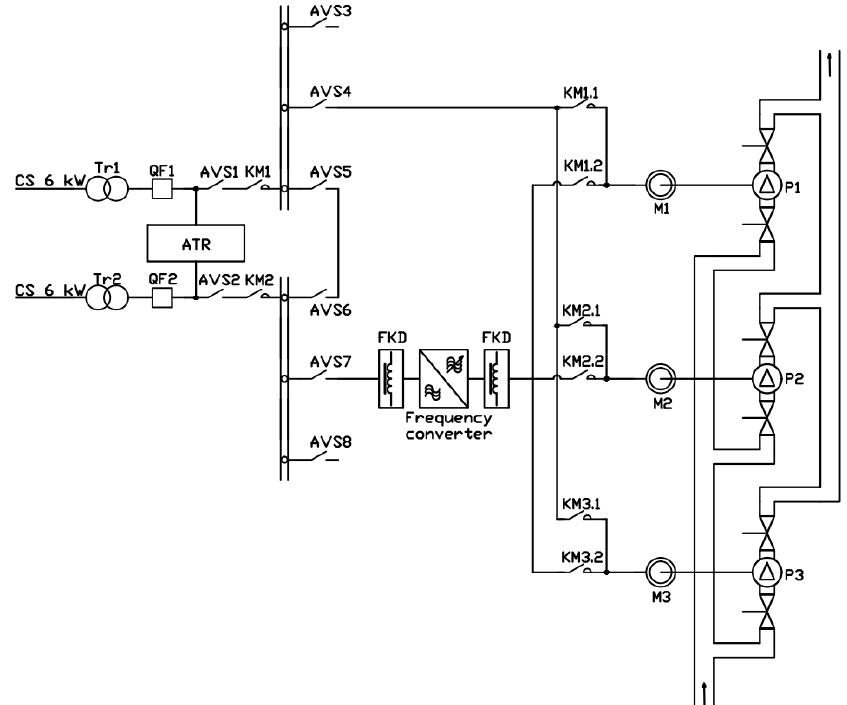
Figure 1. Block diagram of the investigated electric drive. CS—closed switchgear; Tr—transformer; QF—circuit breaker; ATR—automatic transfer of reserve; AVS—automatic vacuum switch; FKD— filter-compensating devices; KM—magnetic contactor; M-asynchronous motor; P—pump.